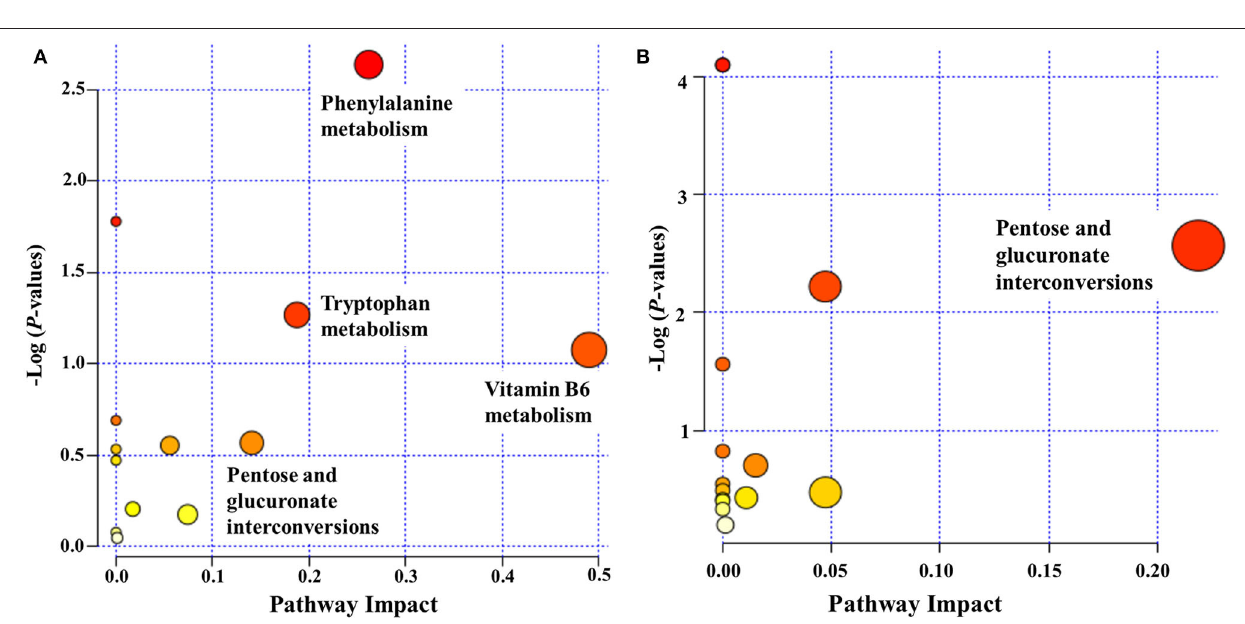
FIGURE 4 | The PLS-DA score plots from ASD case (red) and TD control (green) in positive ion mode (A) and negative ion mode (B) .